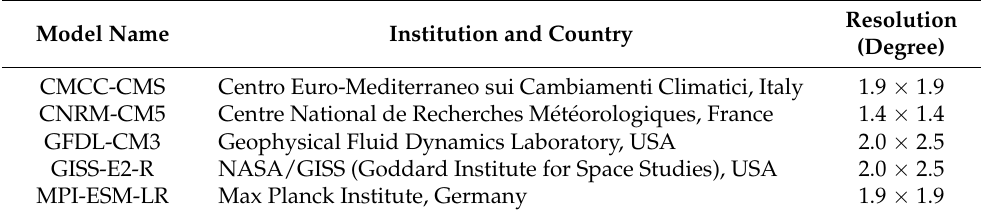
Table 1. GCMs used in the current